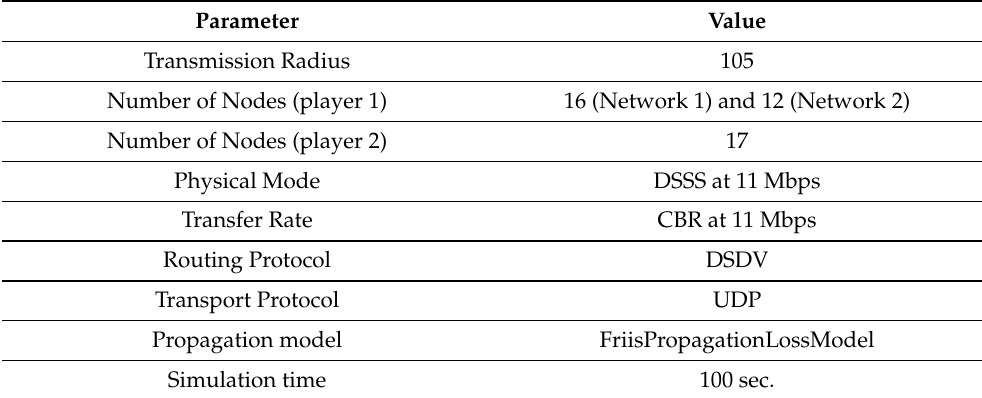
Table 5. Simulation